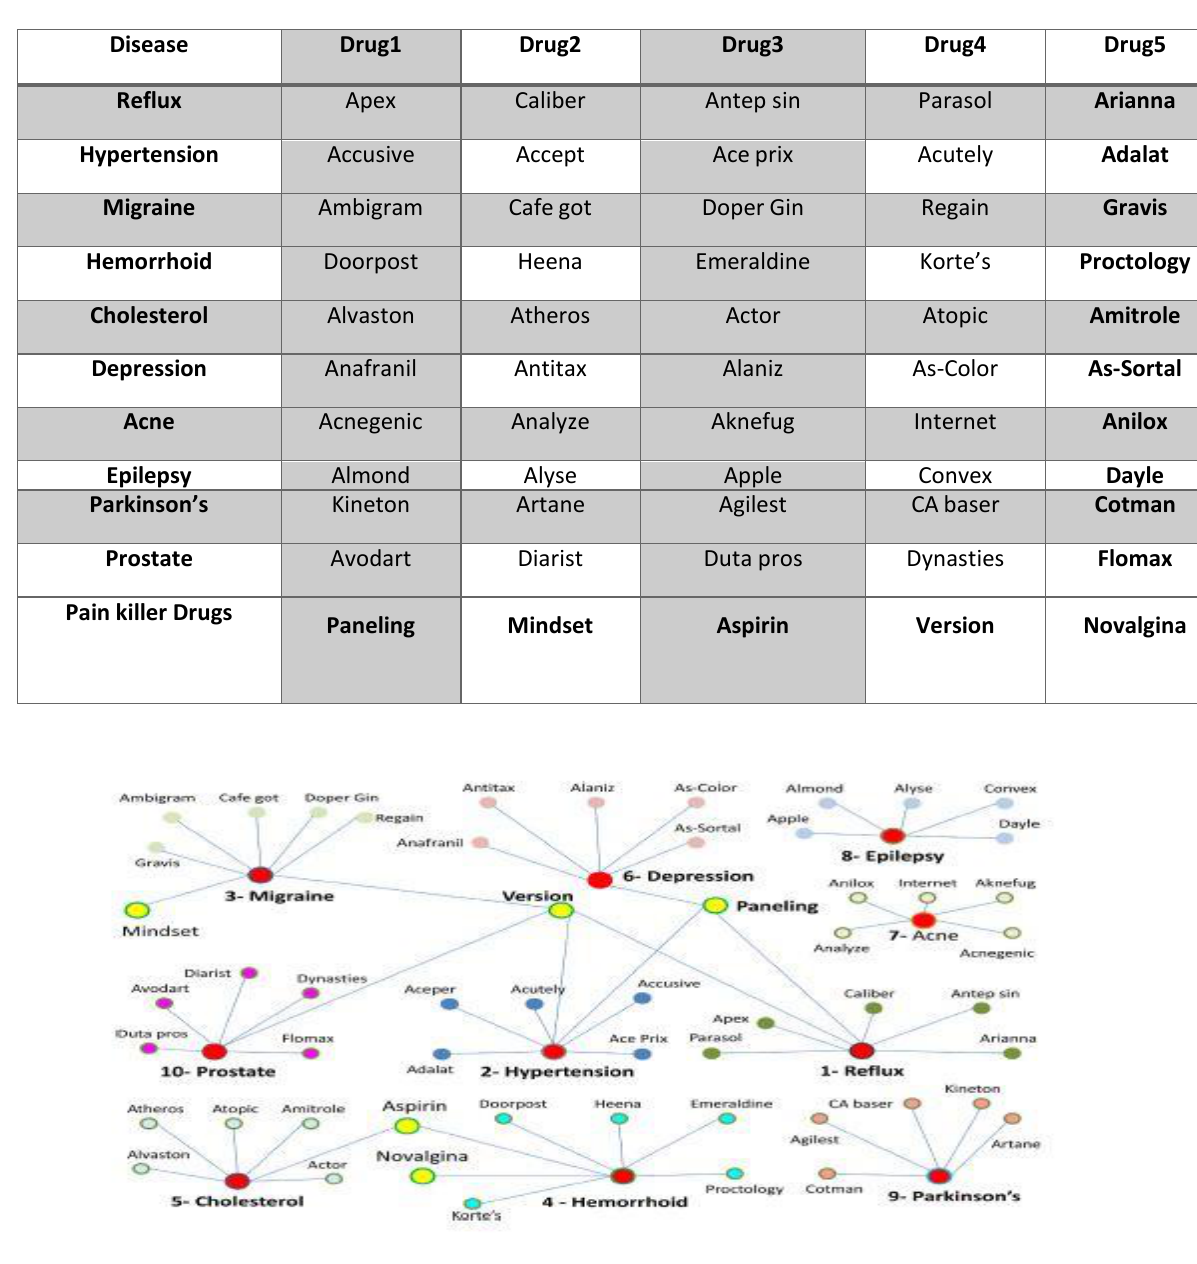
Fig. 6. Disease-Drug